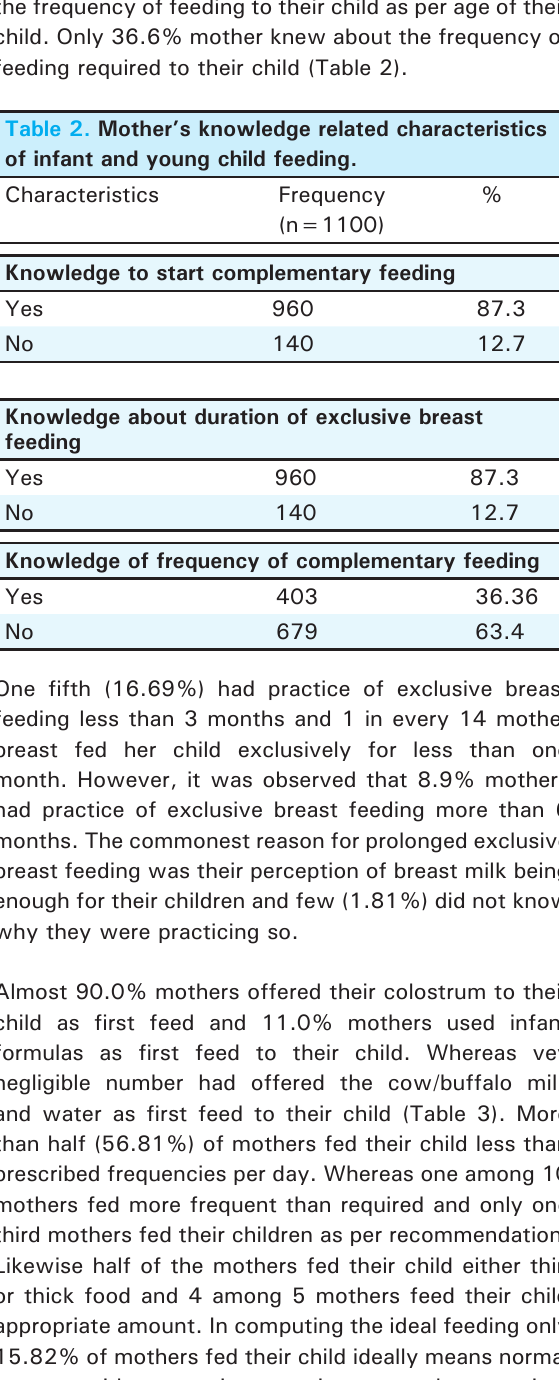
Table 3. Practice related characteristics of Infant and young child